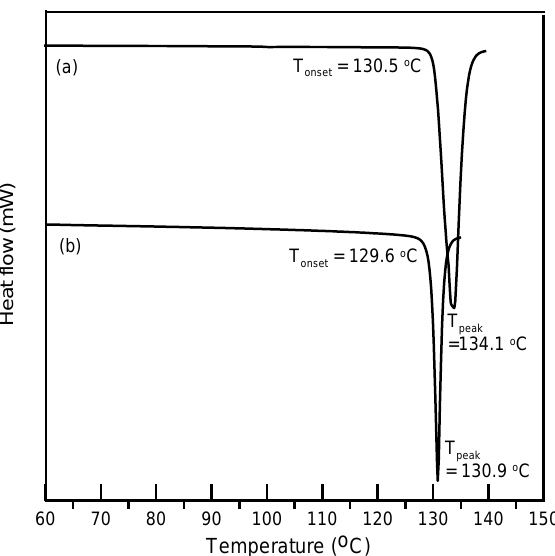
Figure 3. SEM images of ( a ) unprocessed ethenzamide and ( b ) RESS-processed ethenzamide from Experiment 12.